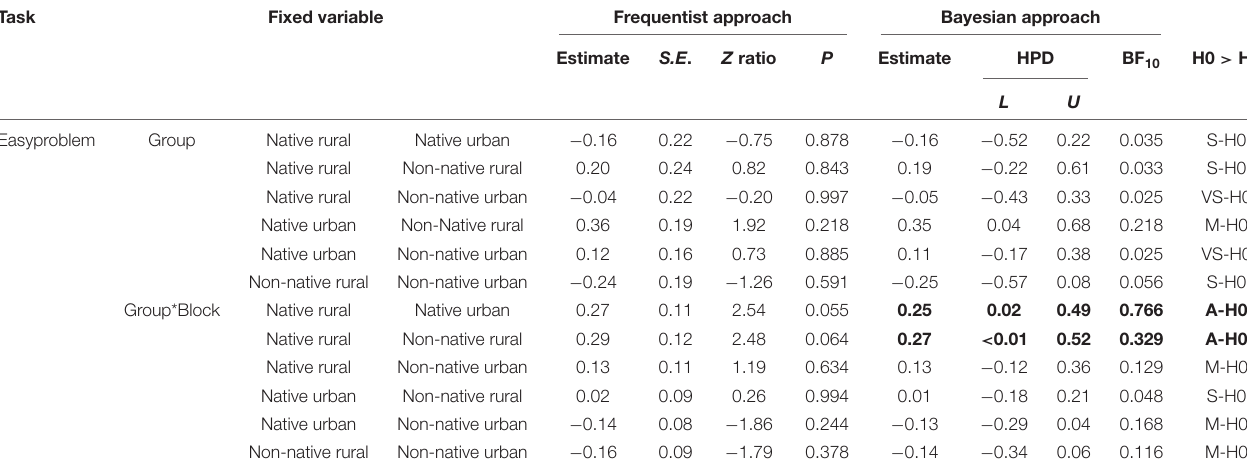
TABLE 2 | GLMM and Bayesian test on the effect of squirrel group (native rural, native urban, non-native rural, and non-native urban group), success block number, and their interaction (Group*Block) on solving latency of the easy problem. Task Fixed variable